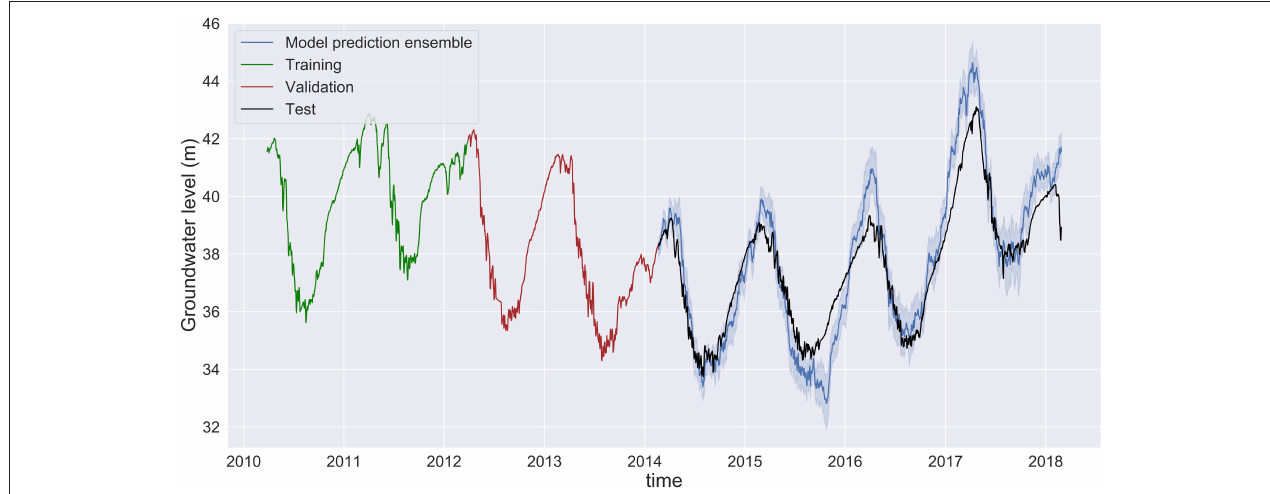
FIGURE 9 | Groundwater level prediction at Butte with input features: groundwater level, temperature, precipitation, and river flow when using only 2 years of data each for hyperparameter optimization process and training. The MLP is able to capture the seasonality of the groundwater levels, and it reflects well the groundwater levels during the drought years and the wet